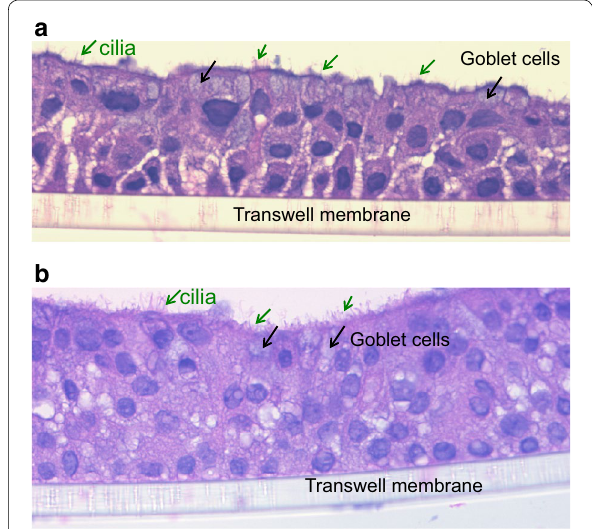
Fig. 2 Mucociliary differentiation of brushed bronchial ( a ) and nasal ( b ) epithelial cells grown at the air–liquid-interface for 14 days. H&E staining, original magnification ×